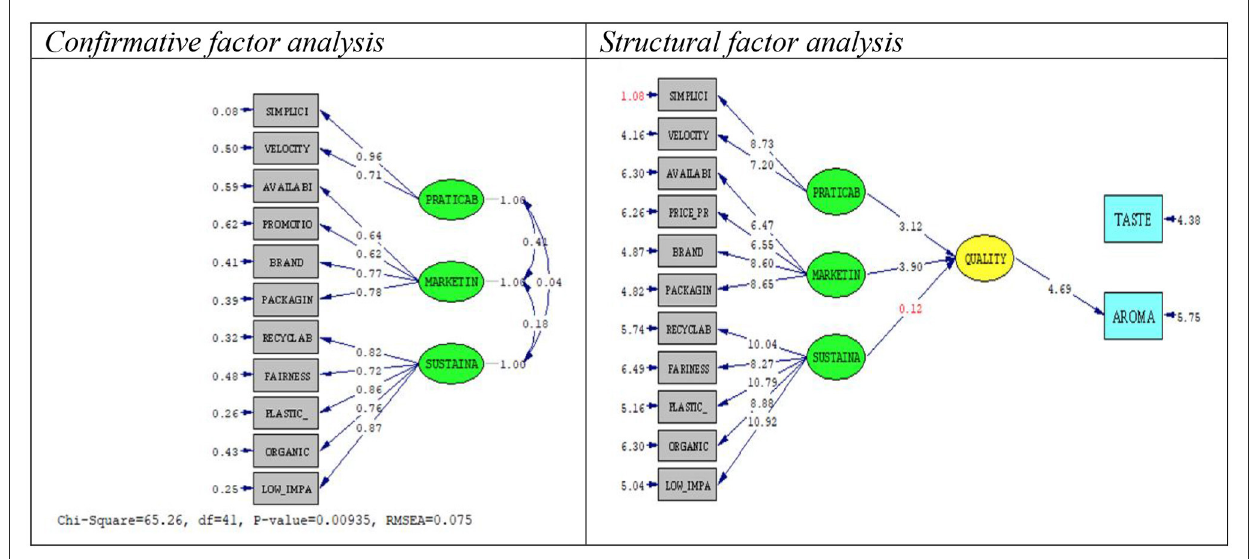
FIGURE4 Confirmative and structural analysis for younger consumers.